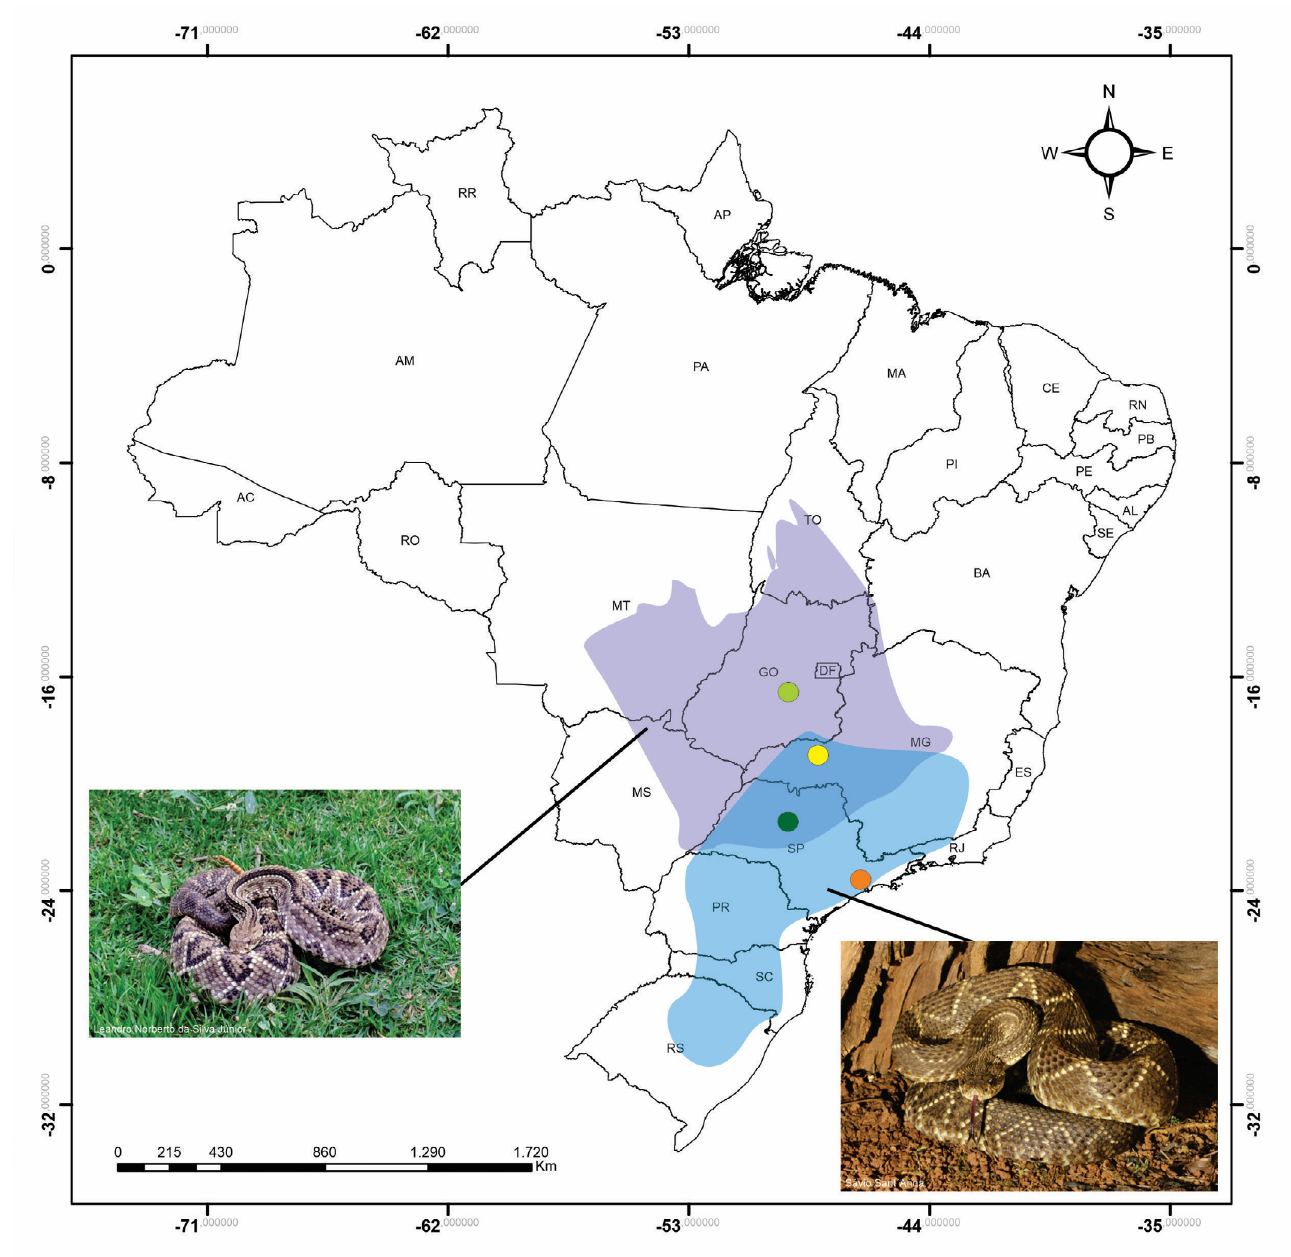
Figure 1. Geographic distribution of C. d. collilineatus (purple) and C. d. terrificus (blue) and geographic origin of the specimens used throughout this study. The dots indicate the geographic origin of the specimens selected for this work. Light green dot: C. d. collilineatus from Goiás state; dark green dot: C. d. collilineatus from São Paulo state; yellow dot: C. d. terrificus from Minas Gerais state; orange dot: C. d. terrificus from São Paulo state.